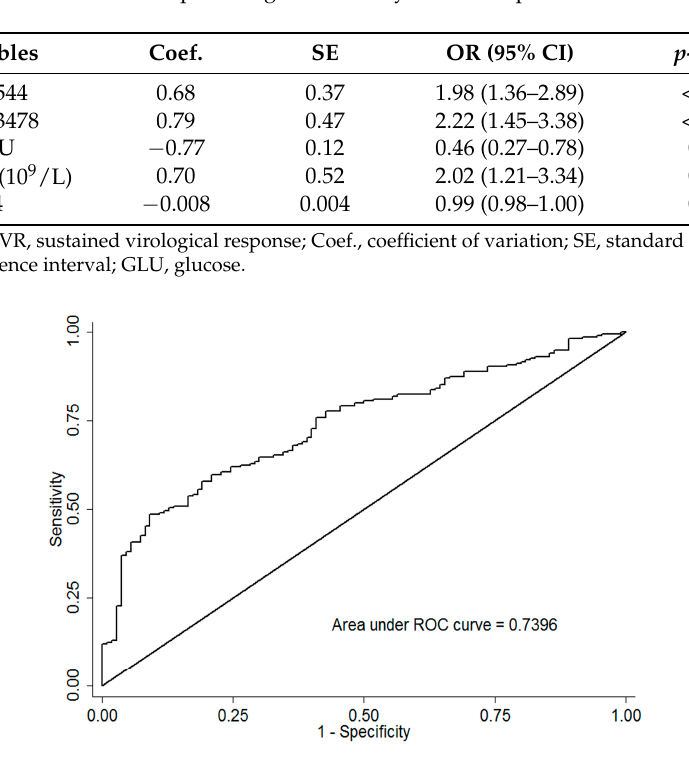
Figure 1. Predictors of hepatitis C virus treatment response.